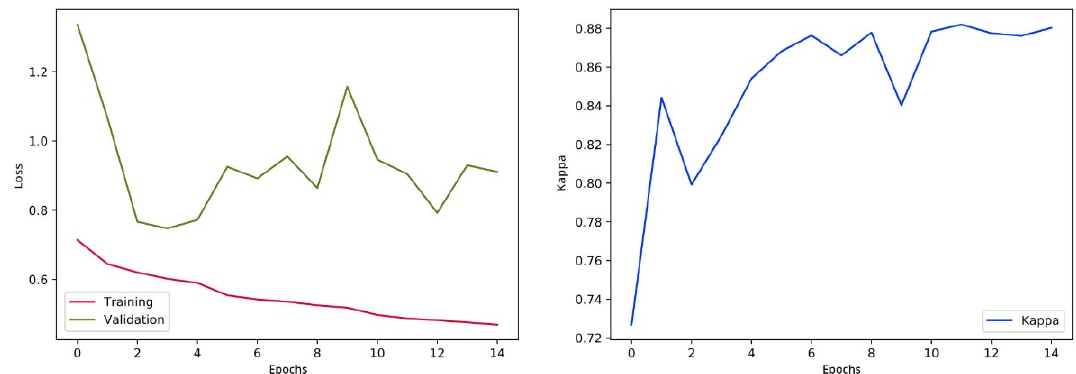
Figure 10. Validation loss and training visualization pre-fine-tuning.